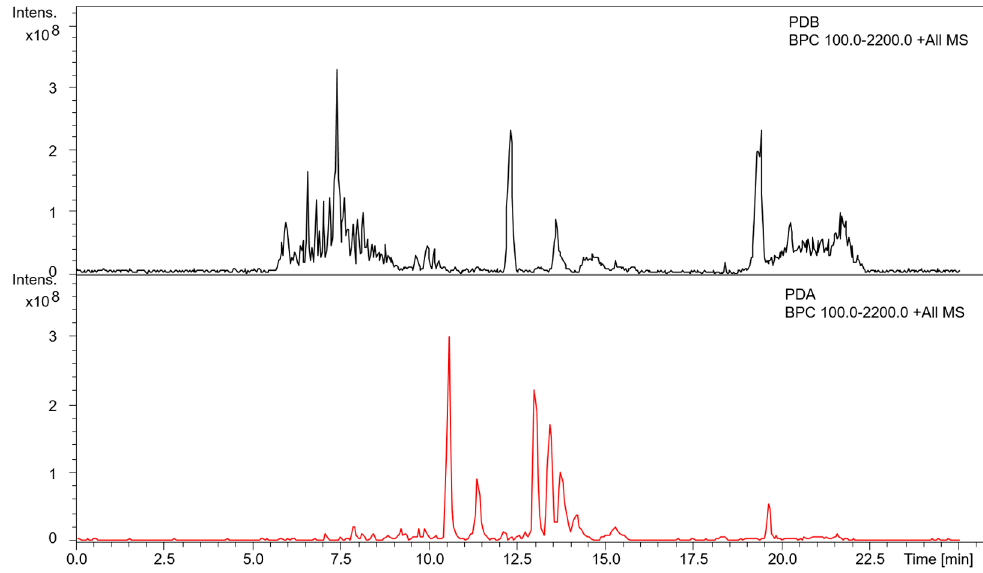
Figure 3. Base peak chromatographs (BPC) of extracts from potato dextrose broth (PDB) liquid culture supernatants and potato dextrose agar (PDA) culture extracts. Intens.: Relative intensity of ions.